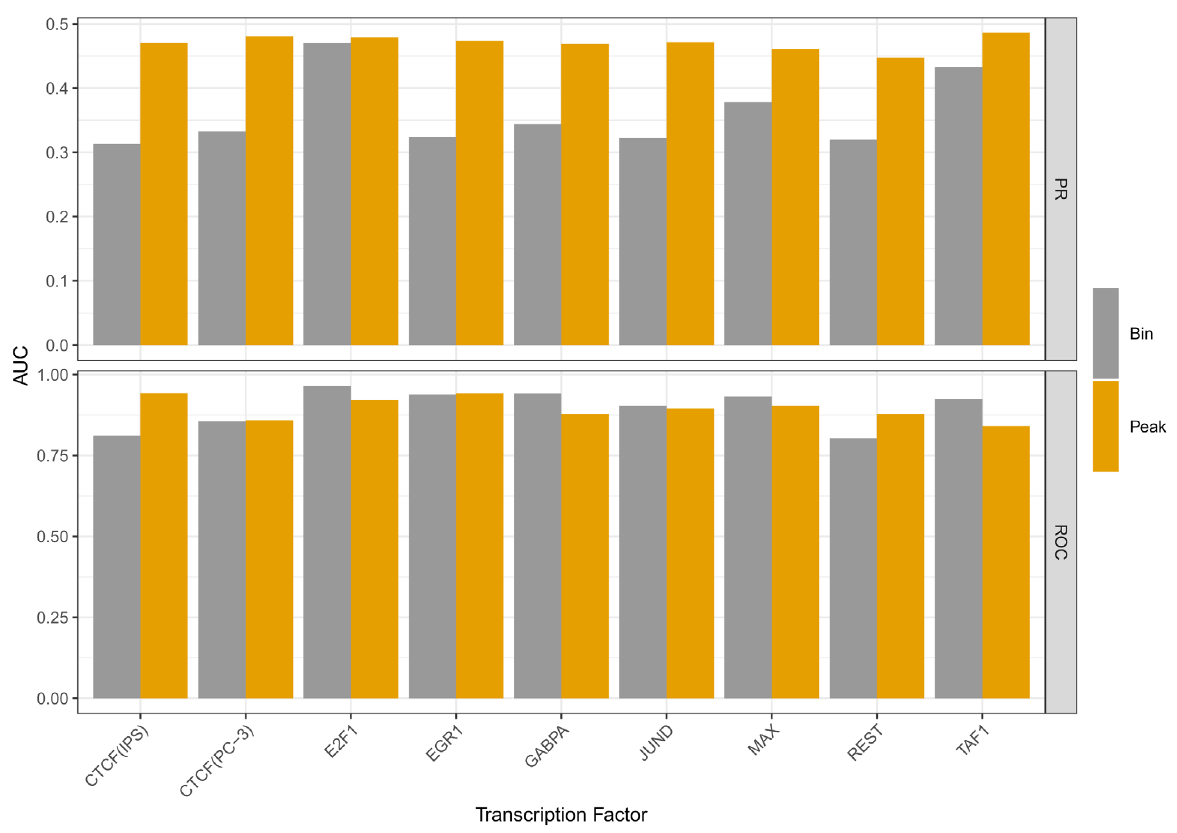
Figure 6. Comparison of PR-AUC and ROC-AUC for both feature setups computed on test data. In terms of PR-AUC, the peak based models clearly perform better than the bin based models. In terms of ROC-AUC it is less clear, however, as the test data is highly unbalanced, ROC-AUC is less reliable than